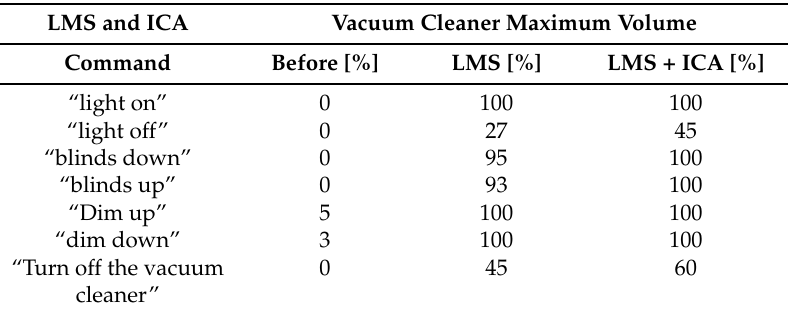
Table 7. The results of recognition success rate for vacuum cleaner interference.